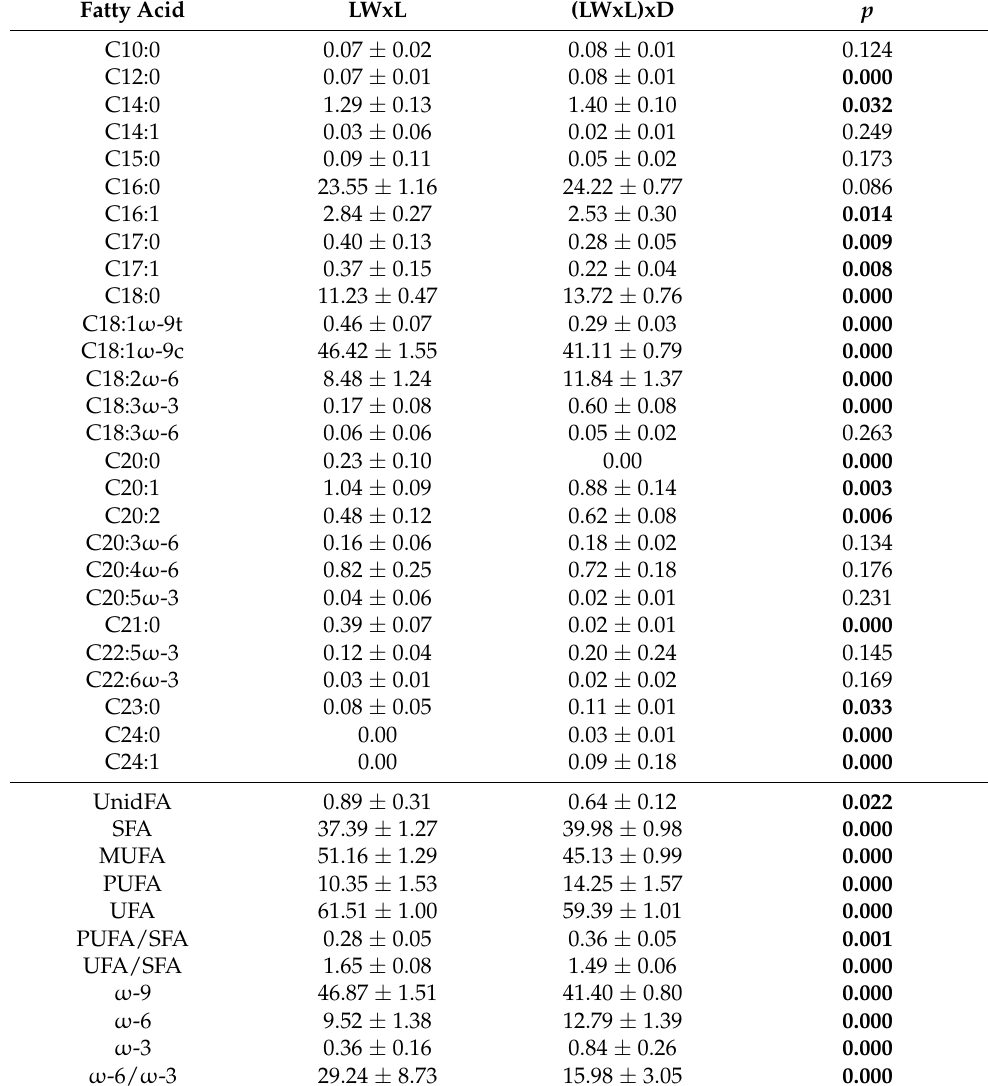
Table 5. Differences between pig genotypes in fatty acid properties (means ± standard error) of matured Istarski pršut